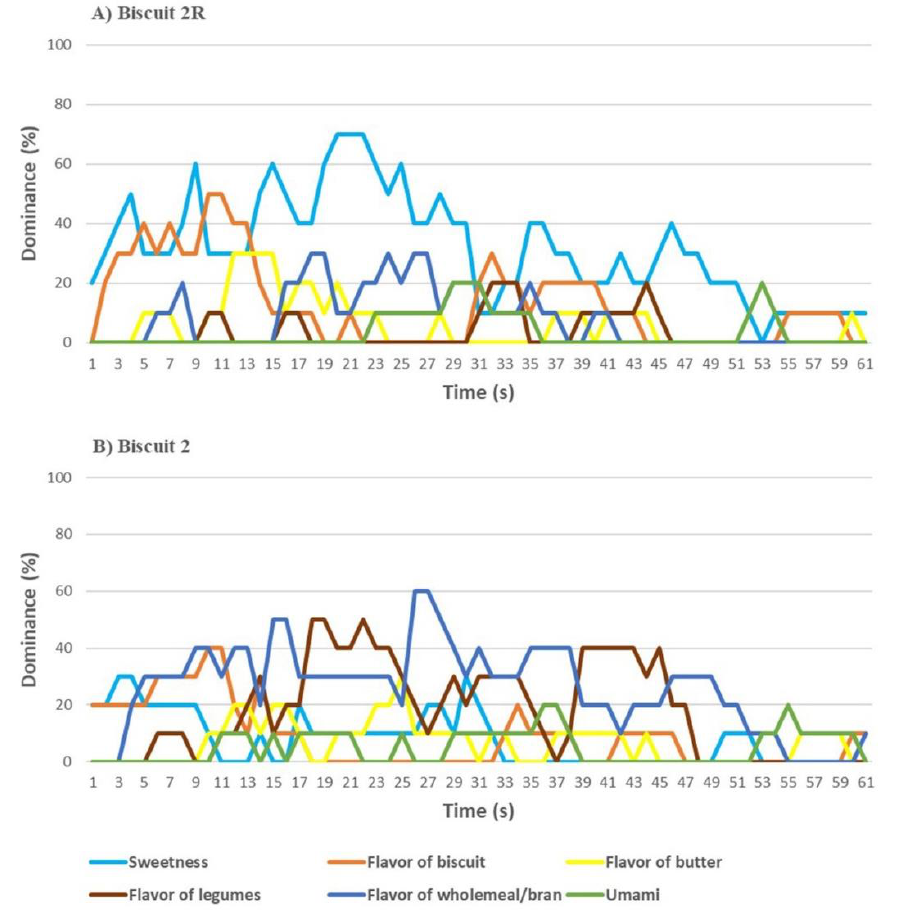
Figure 9. Temporal dominance of sensations (TDS) of ( A ) Biscuits 2R (reference, without common bean flour) and ( B ) Biscuit 2 (with 14% common bean flour).